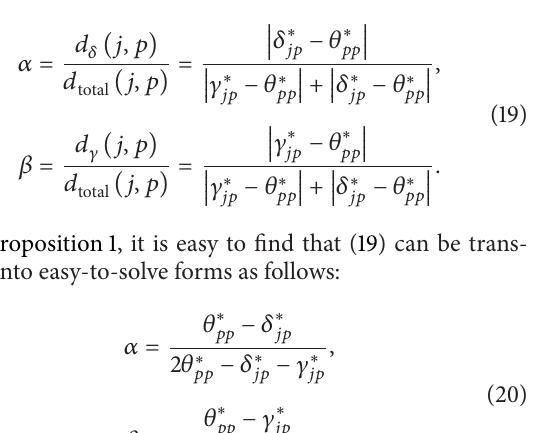
Table 1: Description of the inputs and the outputs of 14 passenger